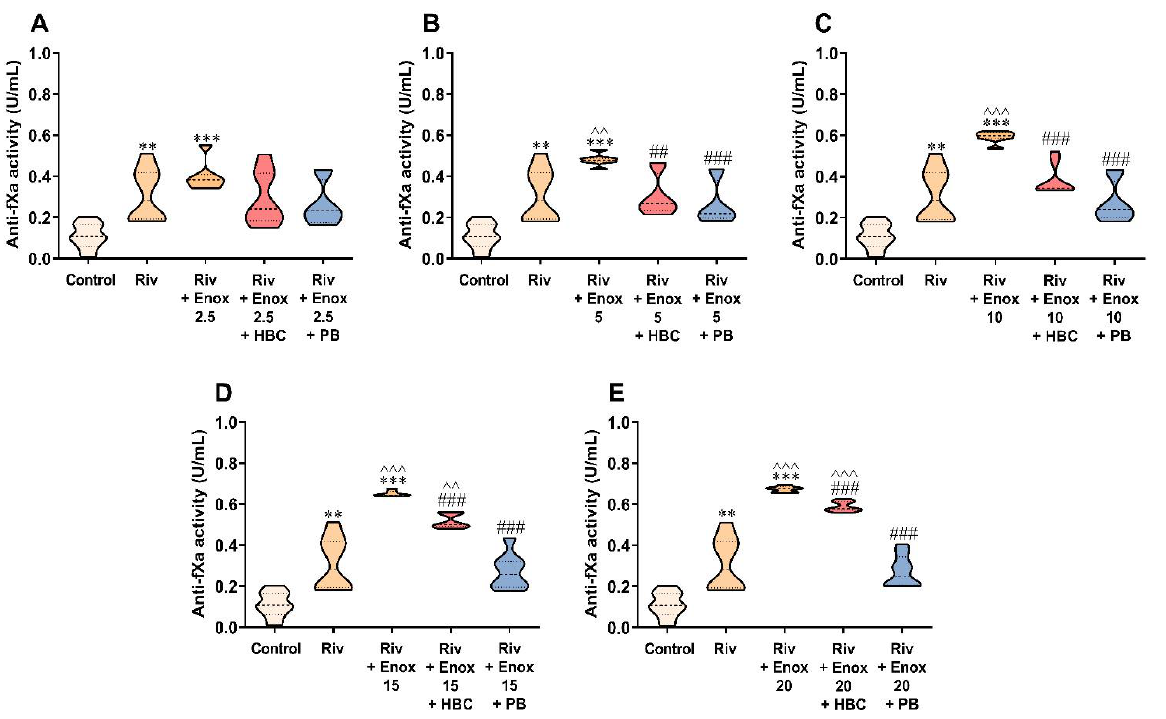
Figure 6. Inhibition of enoxaparin at a concentration of 2.5 ( A ), 5 ( B ), 10 ( C ), 15 ( D ), and 20 µ g/mL ( E ) by HBC (10 µ g/mL) and polybrene (50 µ g/mL) during testing of rivaroxaban (50 ng/mL) anticoagu- lant activity by anti-factor Xa (anti-fXa) activity in human plasma. ** p < 0.01, *** p < 0.001 vs. control; ˆˆ p < 0.01, ˆˆˆ p < 0.001 vs. rivaroxaban; ## p < 0.01, ### p < 0.001 vs. rivaroxaban with enoxaparin, Mann–Whitney test. The results are shown as violin plots with minimum and maximum values and analyzed with GraphPad Prism 8 software. Enox, enoxaparin; HBC, heparin-binding copolymer; PB, polybrene; Riv,